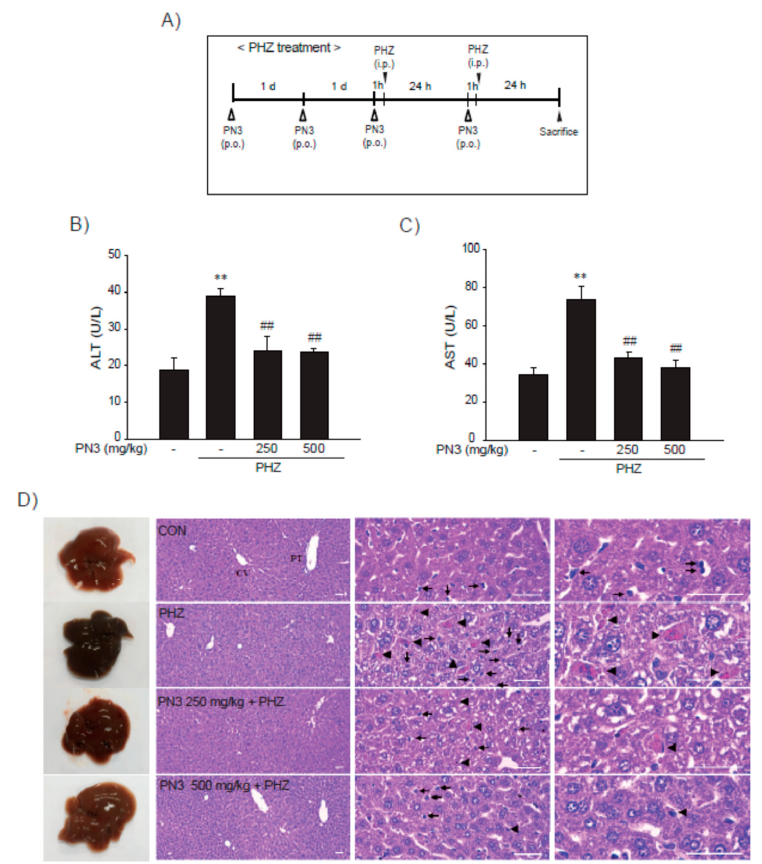
Figure 6. The effect of the ethyl acetate fraction of PN3 on phenylhydrazine (PHZ)-induced liver injury. ( A ) Study design. PN3 (250–500 mg/kg) were used to treat mice for 4 days via oral administration. To induce iron accumulation and liver injury, PHZ (60 mg/kg/day, i.p.) was injected into the mice for the last two days during PN3 administration before they were sacrificed. All mice were sacrificed 24 h after the second PHZ injection. ( B , C ) PN3 inhibited PHZ-induced liver injury. The levels of ALT ( B ) and AST ( C ) were determined using commercial kits. Data represent the mean ± S.D.; ** p < 0.01, significant versus vehicle-treated control; ## p < 0.01, significant versus PHZ alone. ( D ) Representative histological sections of the liver. Samples were fixed in 10% neutral buffered formalin, embedded in paraffin, sectioned (3–4 µ m), and then stained with H and E for general histological observations (scale bar = 120 µ m). Arrow heads and arrows indicate representative degenerative hepatocytes and inflammatory cells, respectively. CV = central vein; PT = portal